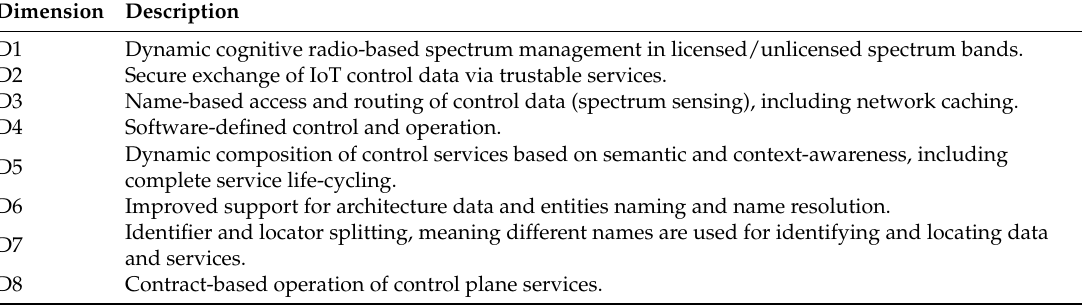
Table 1. Architecture design dimensions considered in this